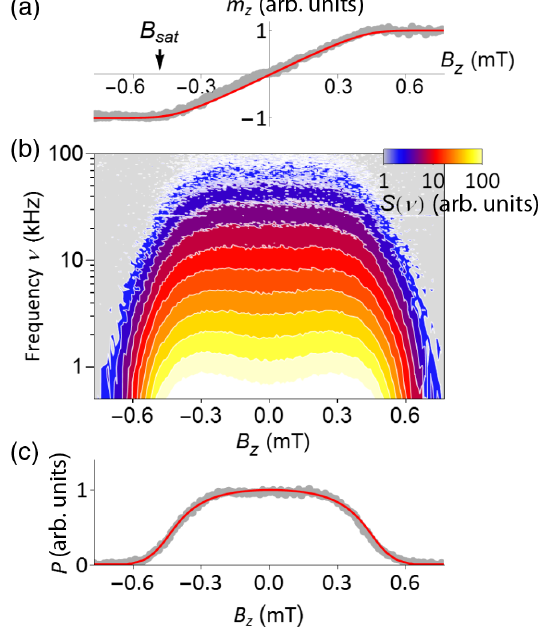
FIG. 4. (a) The average magnetization m z versus applied perpendicular magnetic field B z (measured by conventional MOKE), at a location on the trilayer near the SRT. m z increases linearly with B z (indicating constant magnetic susceptibility χ ¼ dm =dB j B j > B . (b) Intensity z z ), until it saturates for z sat map of the noise spectra S ð ν Þ at different B z . For all j B z j < B , sat S ð ν Þ is unaffected (and follows ν − 3 = 2 ), but S ð ν Þ → 0 when j > B j B . (c) The integrated magnetization noise P ¼ R z sat S ð ν Þ d ν versus B P and χ is in z . The correspondence between accord with the fluctuation-dissipation theorem. Moreover, the detailed dependence of P (and m z ) on B z can be qualitatively captured by simple considerations of the free energy of a mixture of magnetic domains, as shown by the red lines in (c) and (a); see